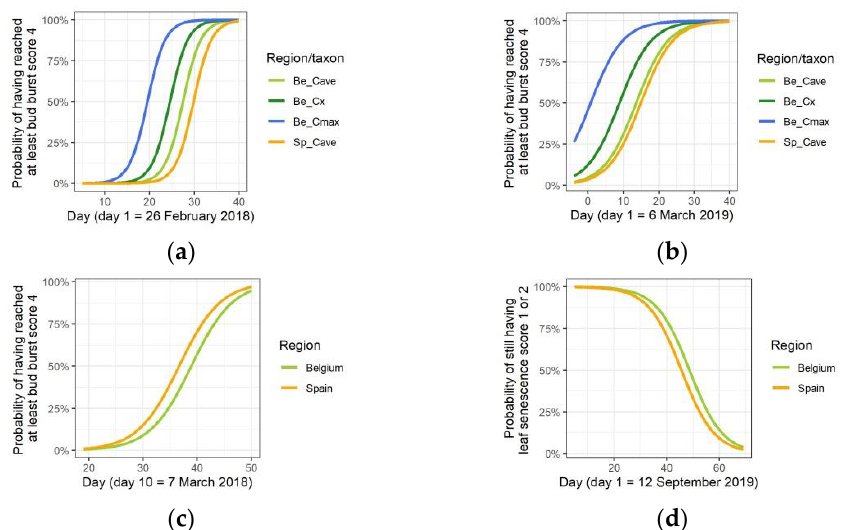
Figure 5. Modeled probability of having reached at least a given bud burst score ( a – c ) or maximally a given leaf senescence score ( d ), depending on the taxon/region for the Corylus taxa ( a , b ) and on the region for Cornus sanguinea ( c , d ). All model fits are for an average plant height and for the “cold–cold” temperature treatments in 2018. Abbreviations for the Corylus taxa are in Table 1.